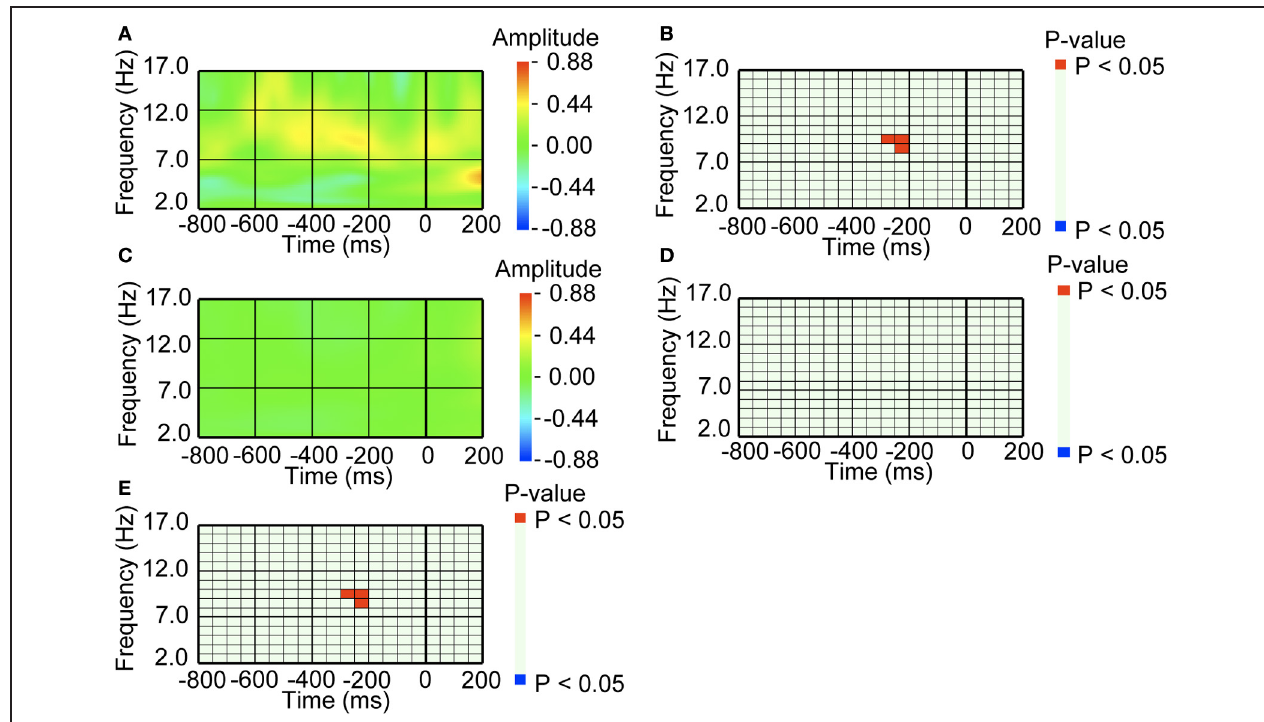
The amplitude was Z-transformed, and zero indicates baseline amplitude. (D) Statistical difference between average waveform aligned with the no-switch blinks and baseline amplitude. The colors red and blue denote that amplitude was larger in average waveform or baseline amplitude, respectively ( P < 0 . 05). (E) Statistical difference between the average waveform aligned with the pre-switch blinks and the average waveform aligned with the no-switch blinks. The colors red and blue denote that amplitudewaslargerinthe pre-switch blinking-related averagewaveformor the no-switch blinking-related average waveform, respectively ( P < 0 .